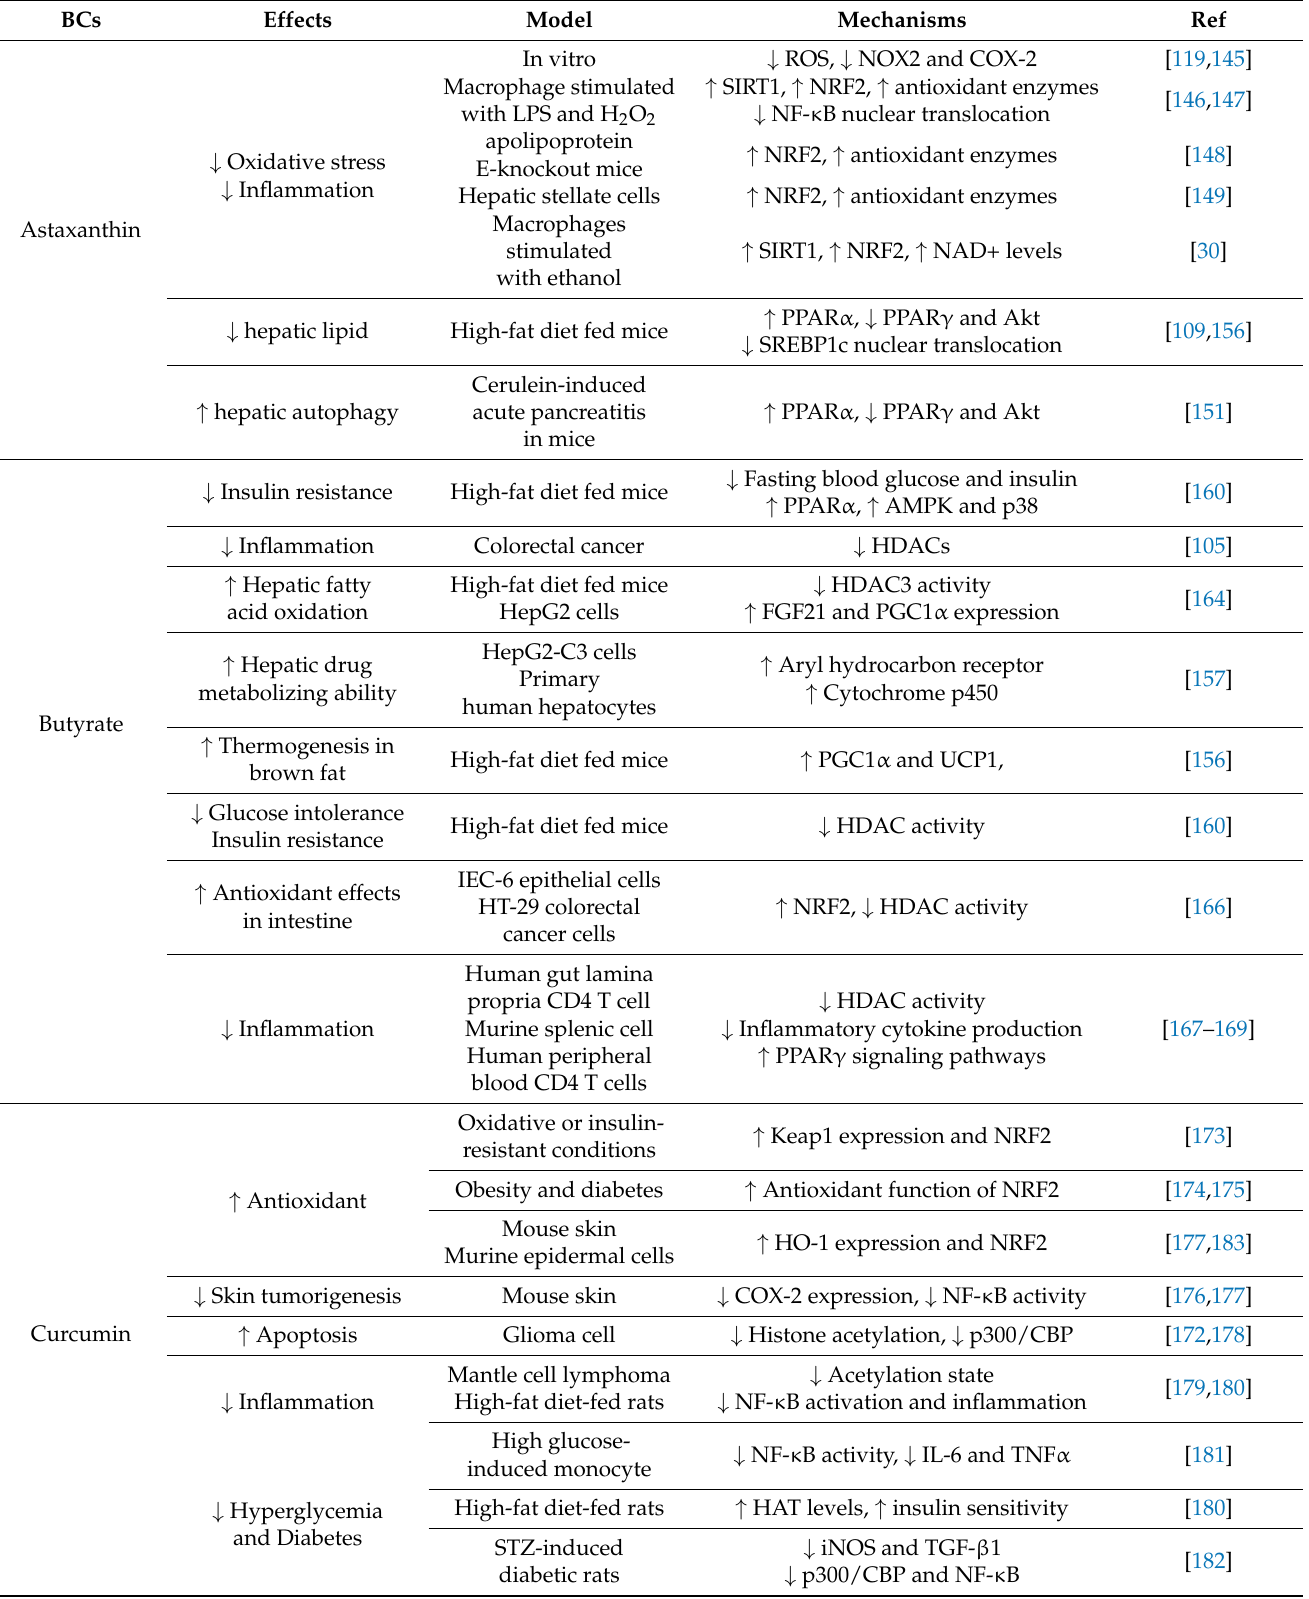
Table 1. BCs regulate cellular redox balance and histone acetylation